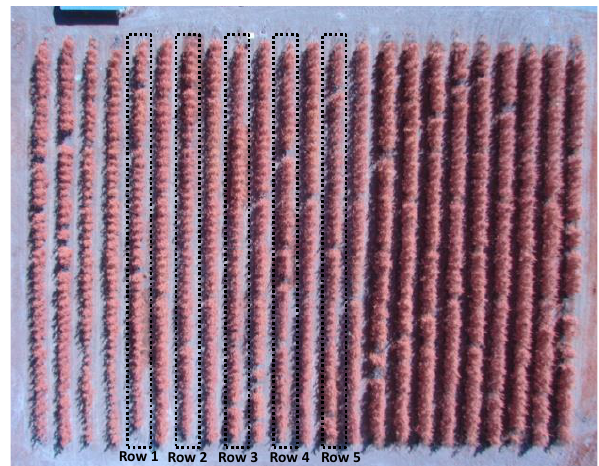
Figure 6. Sample multispectral image of the target orchard.